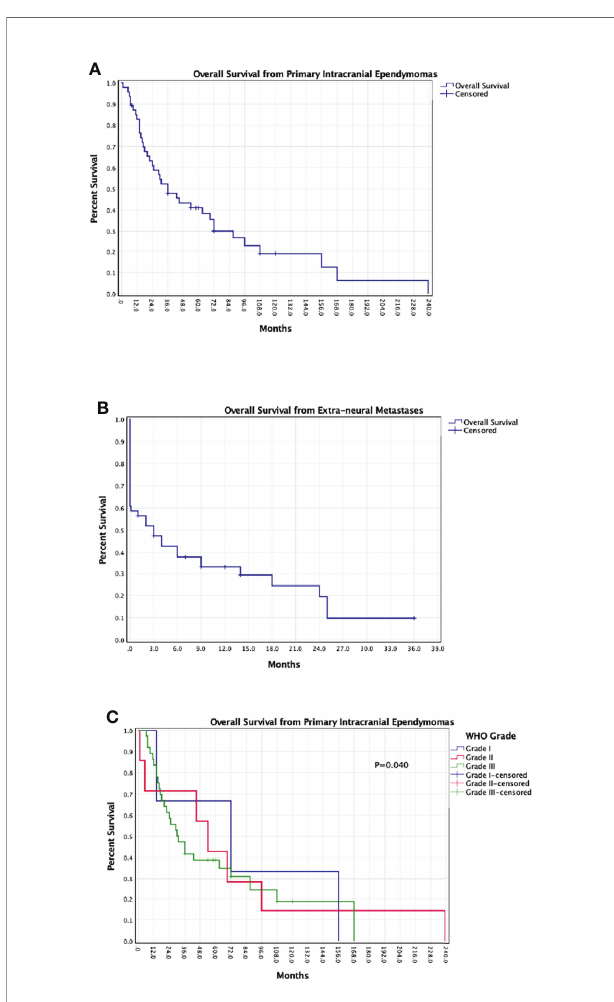
FIGURE 2 | Kaplan-Meier survival curves of all pooled patients: (A) overall survival from diagnosis of primary intracranial ependymoma; (B) overall survival from diagnosis of extra-neural metastases; (C) overall survival from diagnosis of primary intracranial ependymoma based on WHO